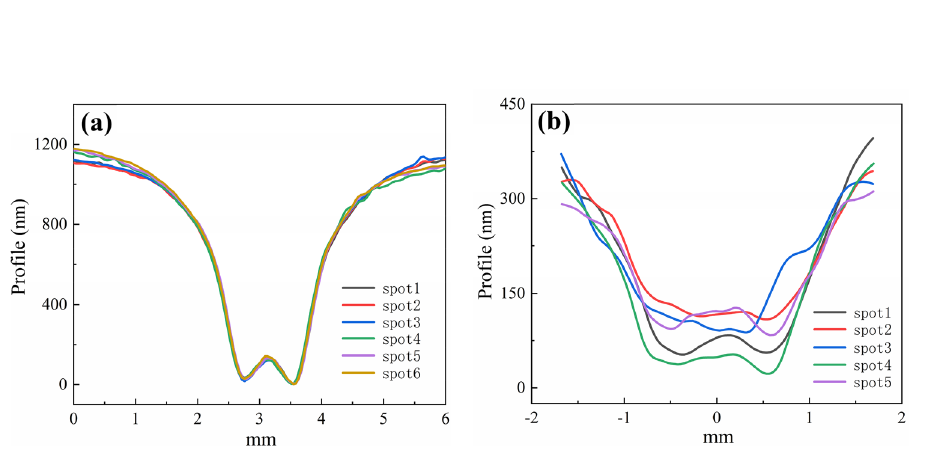
Figure 8. The 2D morphology features of jet spots using ( a ) the BT (the time, pressure and nozzle are 5 min, 0.5 MPa and 1 mm, respectively) and ( b ) the BF (the time, pressure and nozzle are 20 s, 0.5 MPa and 1 mm, respectively 23